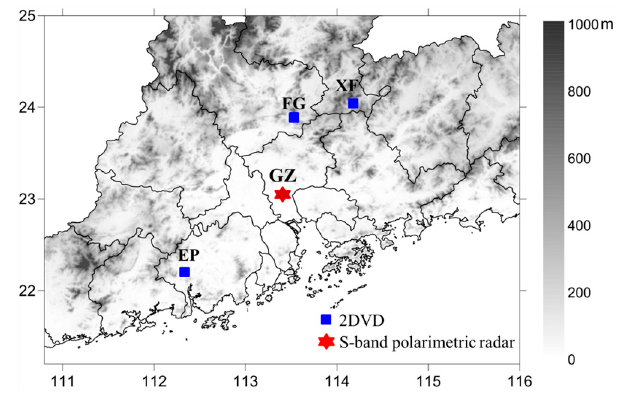
Figure 1. The geographic locations of the instruments in Guangdong used in this study. The three 2D Video Disdrometer (2DVDs) were located at the Enping (EP), Fogang (FG), and Xinfeng (XF) sites. The S-band polarimetric radar was located at the Guangzhou (GZ) site.